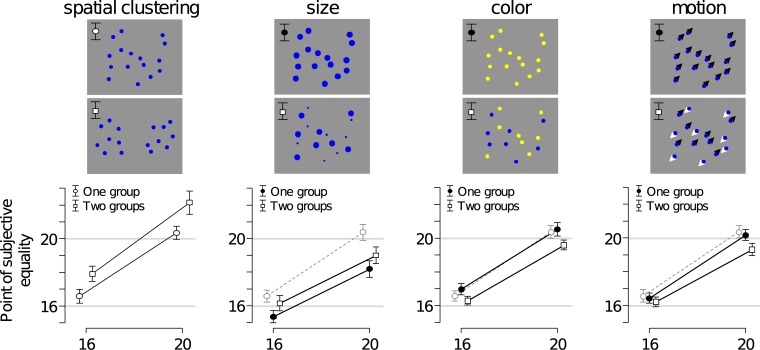
Subject-averaged numerosity estimates across the 8 stimulus conditions in Experiment 1.Subjects matched the number of dots in an adjustable response array to the number of dots in 8 different types of test array. We refer to the estimates as the point of subjective equality. The visual properties of test array in the one-group spatial clustering condition (top left) were identical to those of the response array. For comparison, we replotted the PSEs in this condition (black circles in left graph) in the results for the size, color, and motion conditions (gray circles). Segregating dots into two groups resulted in an increase in perceived numerosity in the spatial clustering and dot-size conditions and in a decrease in the color and motion conditions. Error bars indicate 95% confidence intervals.